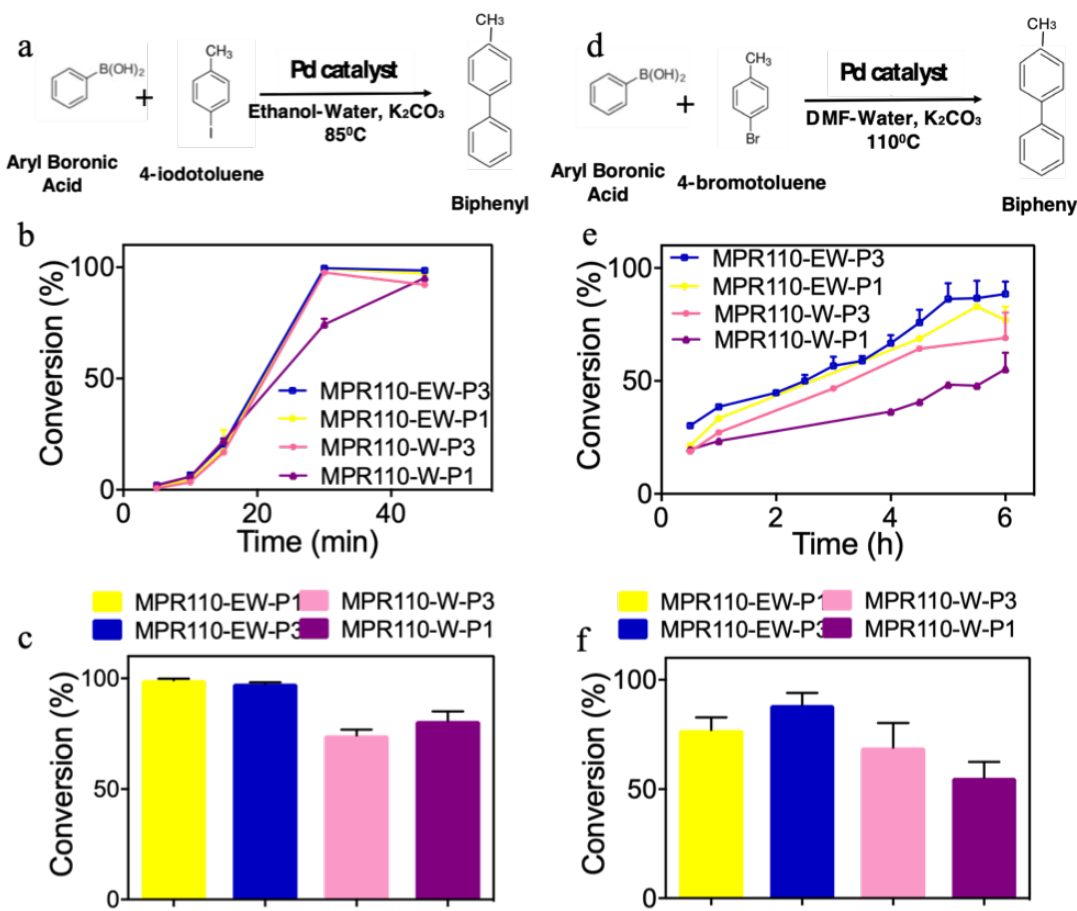
Figure 6. Suzuki-Miyaura reaction in the batch system ( a ) Reaction schematic for Iodotoluene, ( b ) Conversion rate: Conversion % vs. time for Iodotoluene and ethanol as solvent, ( c ) E ff ect of catalyst type on conversion rate for Iodotoluene and aryl boronic acid in the present of ethanol as solvent, ( d ) Reaction schematic for Bromotoluene, ( e ) Conversion rate: Conversion % vs. time for Bromotoluene and DMF as solvent ( f ) E ff ect of catalyst type on conversion rate for Boromotoluene and aryl boronic acid in the present of DMF as solvent (n =